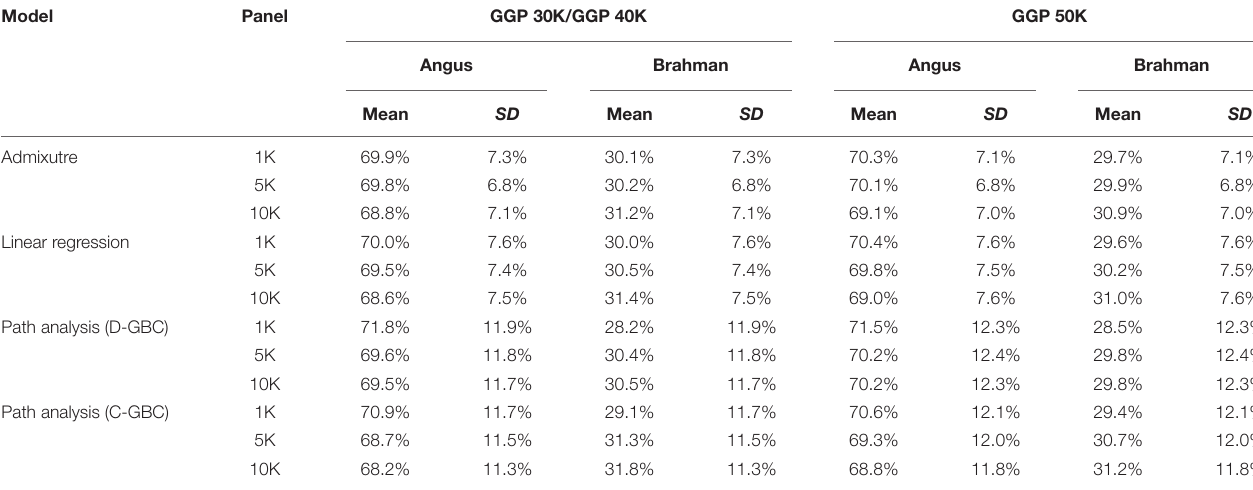
TABLE 4 | Comparison of estimated GBC for 7,969 Brangus with genotype data, obtained by the admixture model, linear regression, and path analysis techniques, respectively, using only Angus and Brahman in the reference breed set.